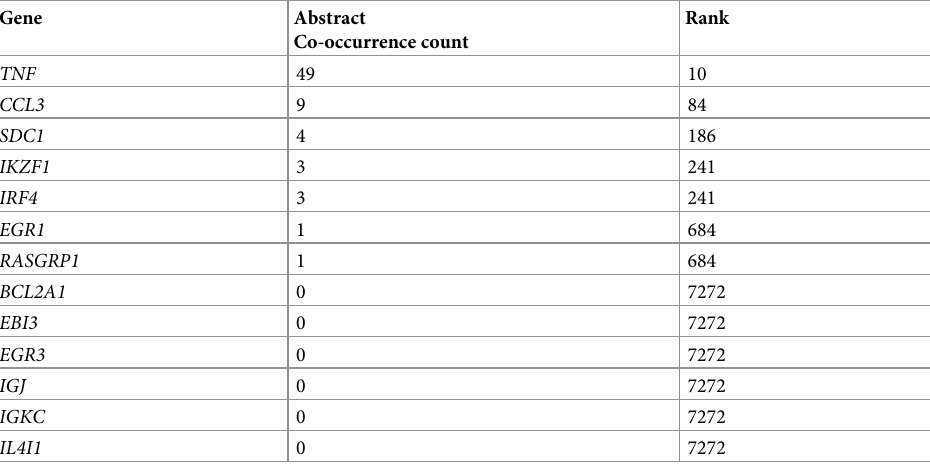
Table 4. Co-occurrence ranking of known BTK targets. Gene Abstract Co-occurrence